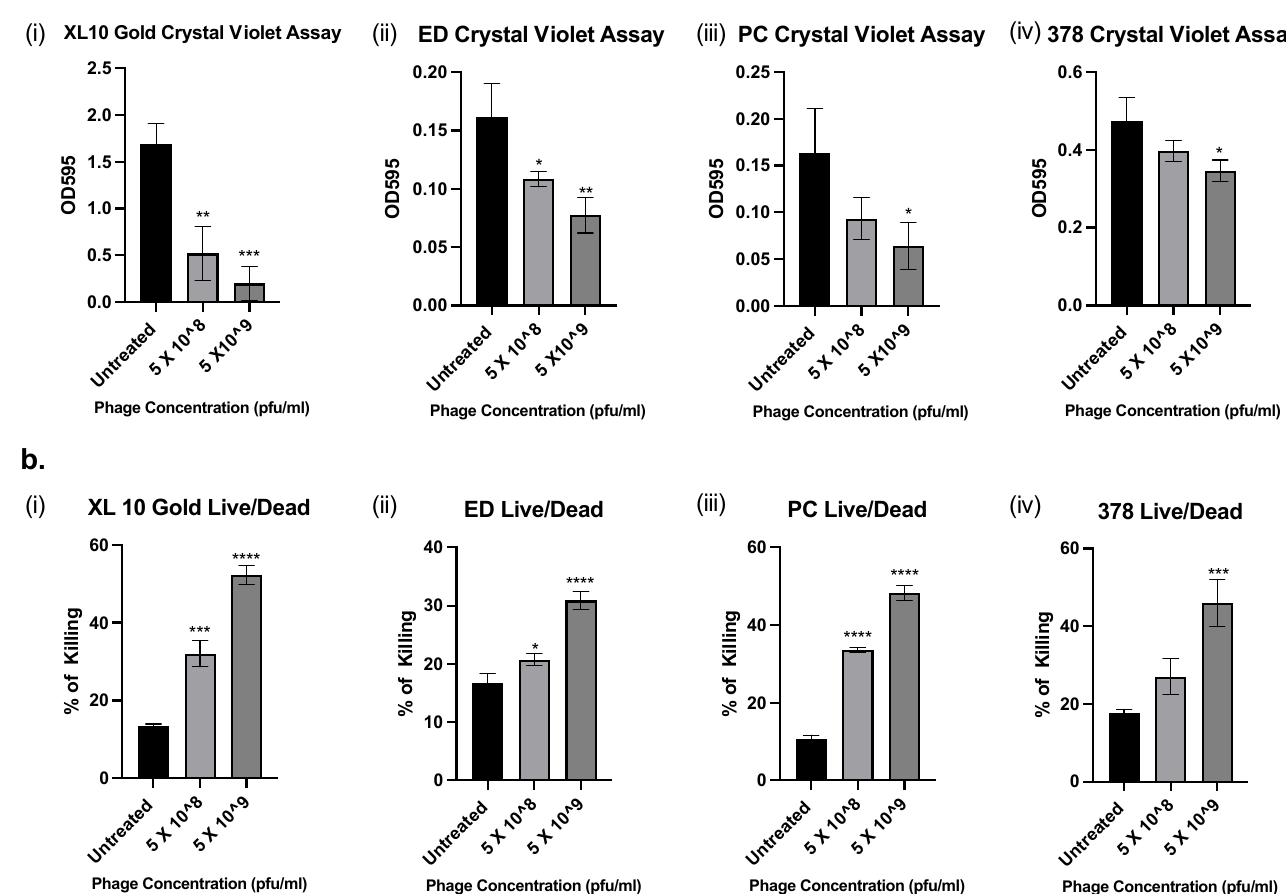
Figure 5. Assessment of biomass of different E. coli biofilms following bacteriophage treatment by ( a ) crystal violet and ( b ) Live/Dead assay. ( i ) XL10 Gold; ( ii ) ED ( iii ) PC and ( iv ) 378 E. coli biofilms were treated with phage APTC-EC-2A at a concentration of 5 × 10 8 pfu/mL and 5 × 10 9 pfu/mL. Biofilm biomass was measured (OD 595) and the percentage killing of E. coli biofilm with significance was determined compared to untreated control. Significance was determined by one-way ANOVA with Dunnett’s multiple comparisons test in comparison with untreated biofilms; p < 0.05 (*); p < 0.01 (**) ; p < 0.001 (***) and (****) p < 0.0001.